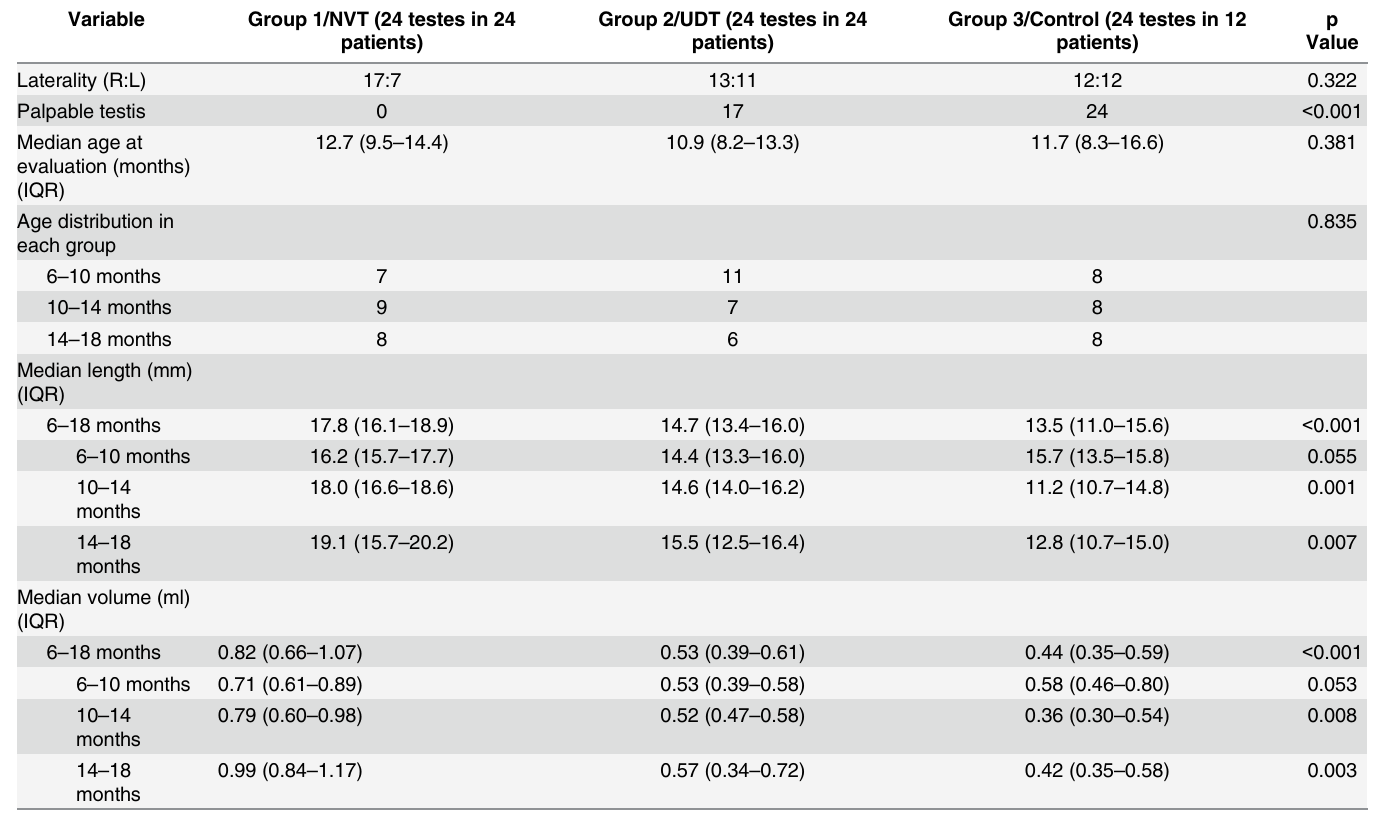
Table 1. Characteristics of 72 testes in 60 patients.